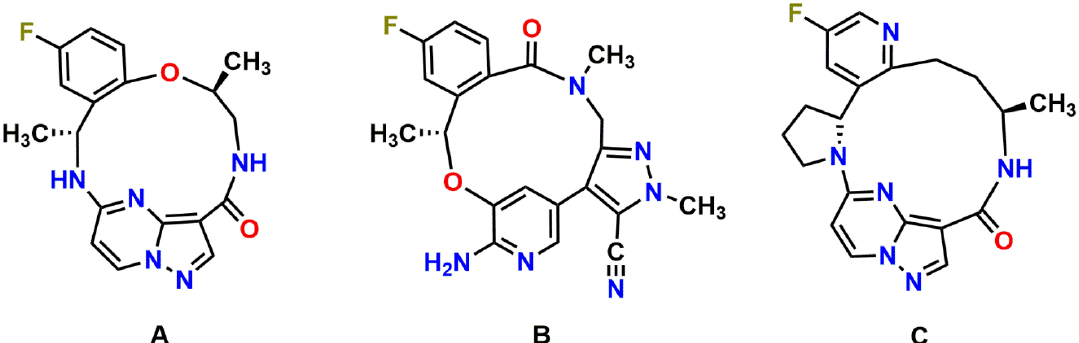
Figure 1. Molecular structures of repotrectinib ( A ) (MW = 355.37 g/mol), lorlatinib ( B ) (MW = 406.42 g/mol), and selitrectinib ( C ) (MW = 380.42 g/mol).